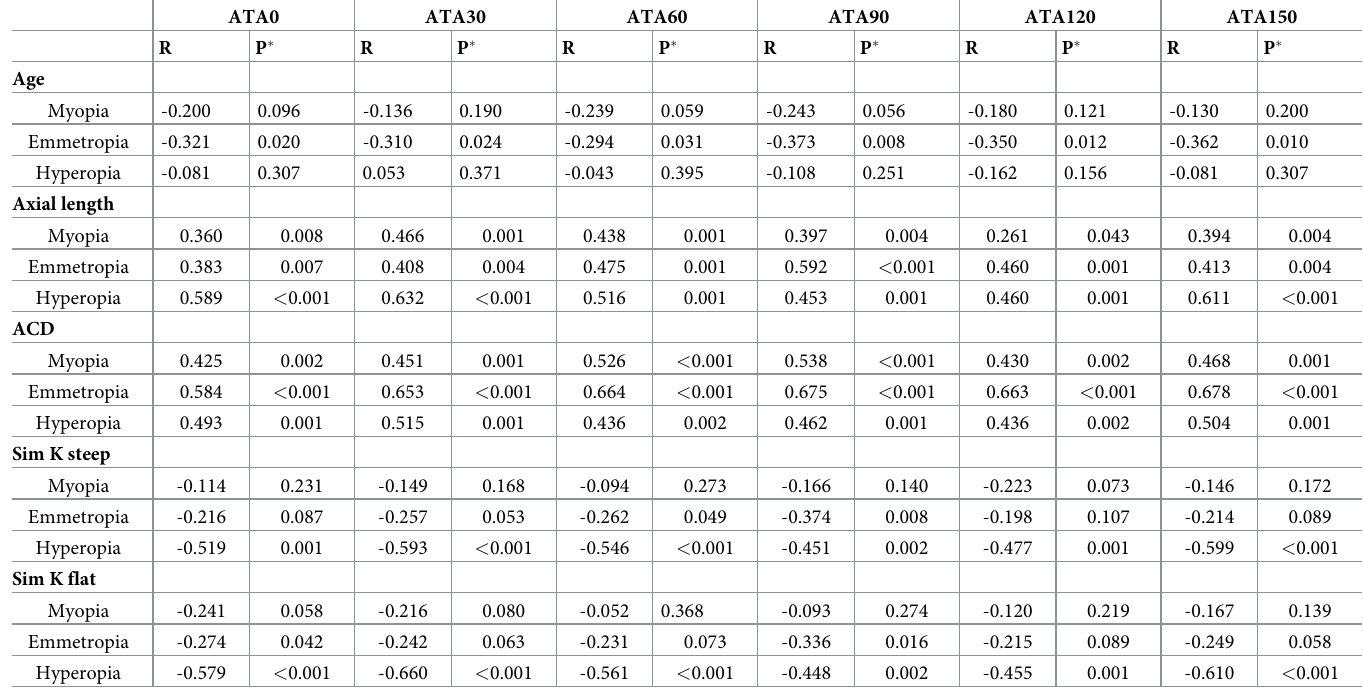
Table 4. Correlation between ATA with age, axial length, anterior chamber depth, and Sim K at different meridians by refractive error. ATA0 ATA30